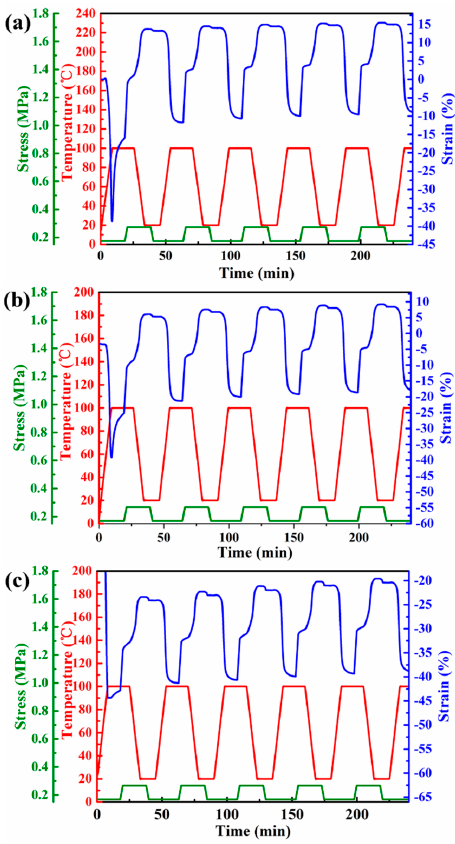
Figure 5. 1W-SME cycles under a constant stress of 0.27 MPa for ( a ) EVA-6M, ( b ) EVA-8M, and ( c ) EVA-10M.